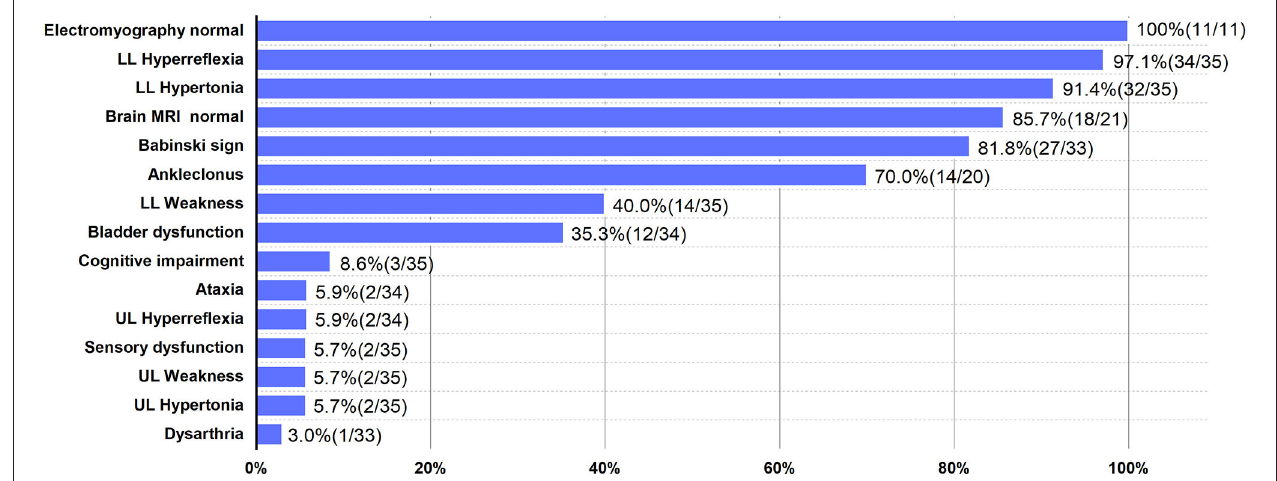
FIGURE 2 | Clinical features of SPG80 probands with UBAP1 mutations. For each clinical manifestation, the proportion of patients is indicated. UL, upper limbs; LL, lower